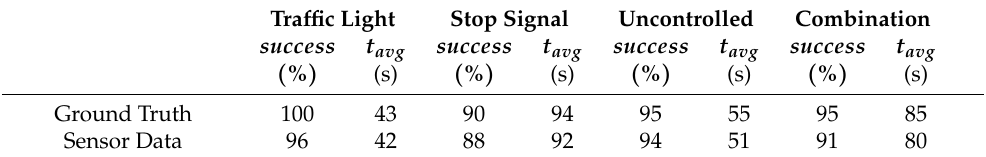
Table 5. Evaluation metrics results in SUMO simulator: ground truth vs. sensor data simulation.